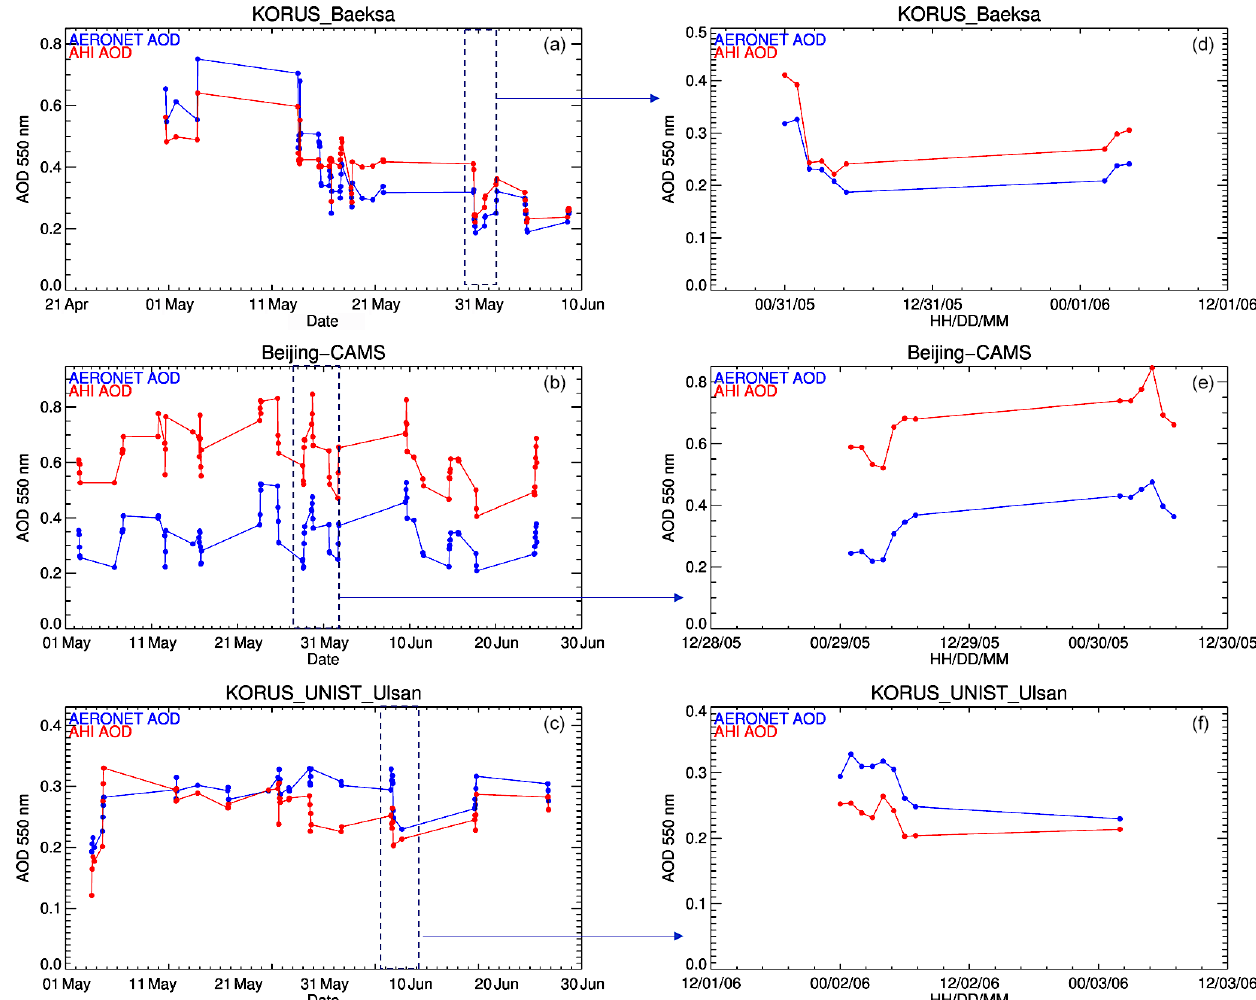
Figure 8. The time series of spatiotemporal mean AODs from AERONET (blue) and AHI (red) for each hour of observation during the KORUS-AQ field campaign for the same three stations as shown in Fig. 7 (a–c) . (d–f) Zoom of selected days as shown in the box with dotted lines in the left panels for each